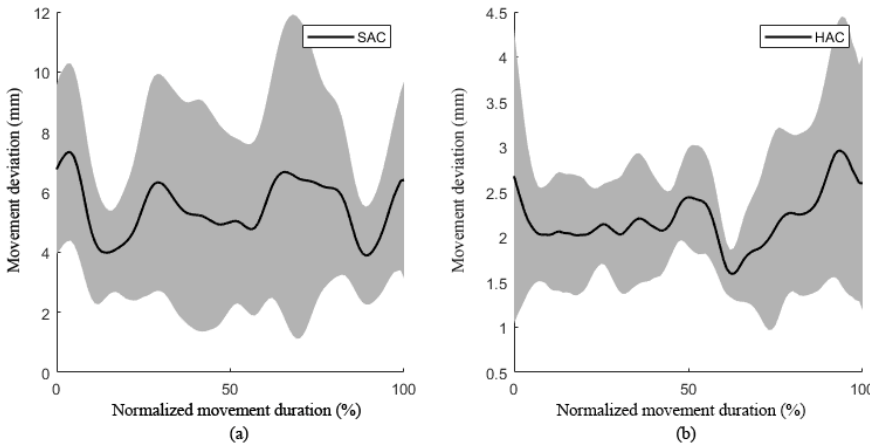
Figure 11. Movement deviation during movement: ( a ) movement deviation during movement of stroke patients; ( b ) move- ment deviation during movement of healthy subjects. stroke patients; ( b ) movement deviation during movement of healthy subjects.